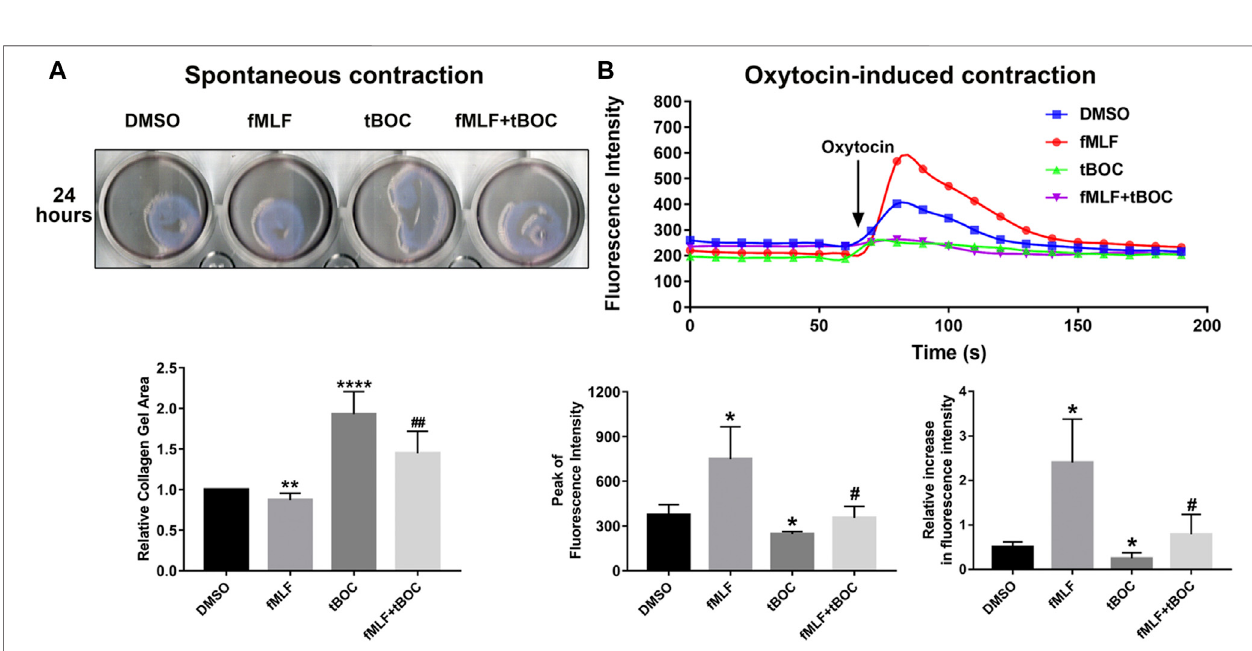
Frontiers in Pharmacology |